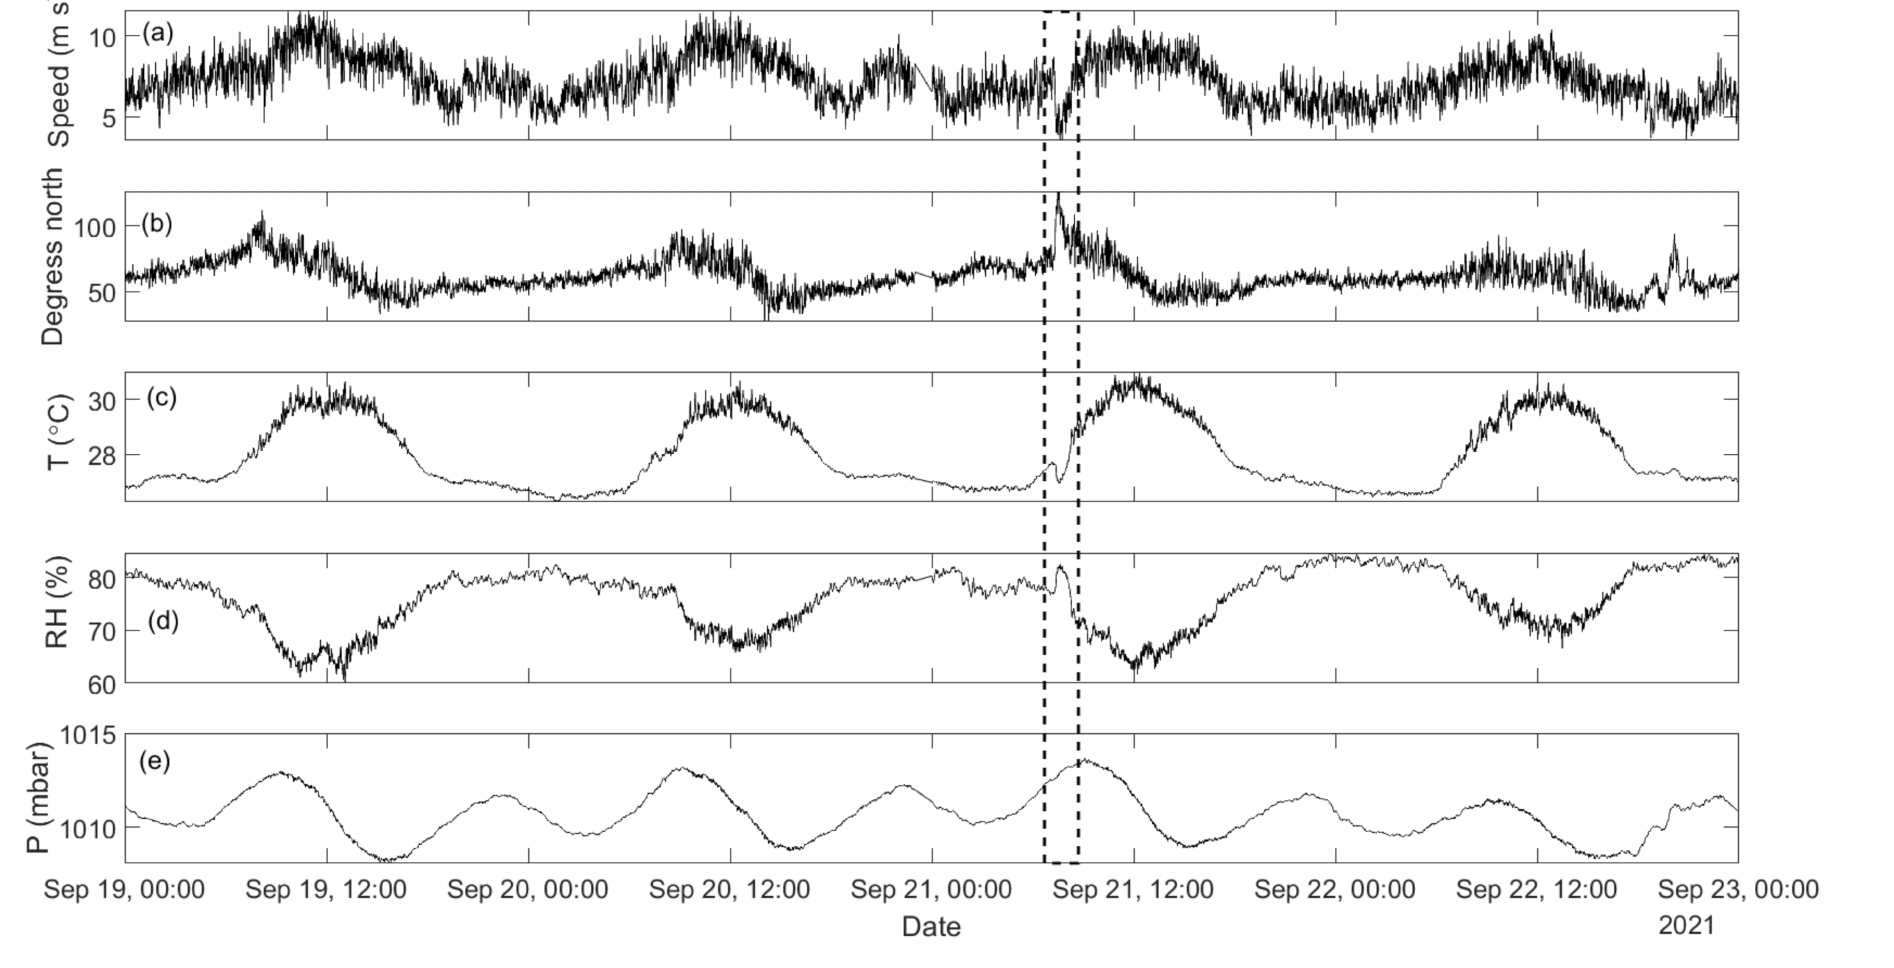
Figure 10. Time series over the period of 19 to 23 of September for ( a ) wind speed; ( b ) wind direction; ( c ) air temperature; ( d ) relative humidity; and ( e ) atmospheric pressure. A vertical dashed bar indicates the meteorological phenomenon of interest (21 September, between 07:00 h and 08:30 h